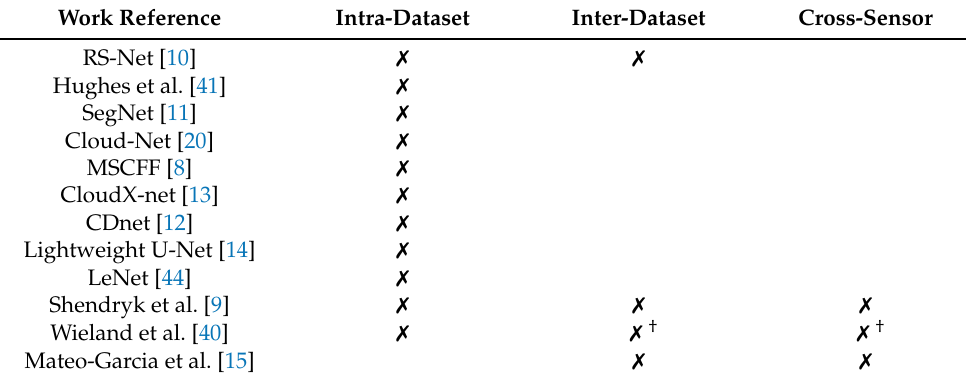
Table 2. Summary of the validation schemes used in different works in the literature related to deep learning-based methods applied to cloud detection in Landsat-8 and Sentinel-2 imagery. MSCFF, multi-scale feature extraction and feature fusion.